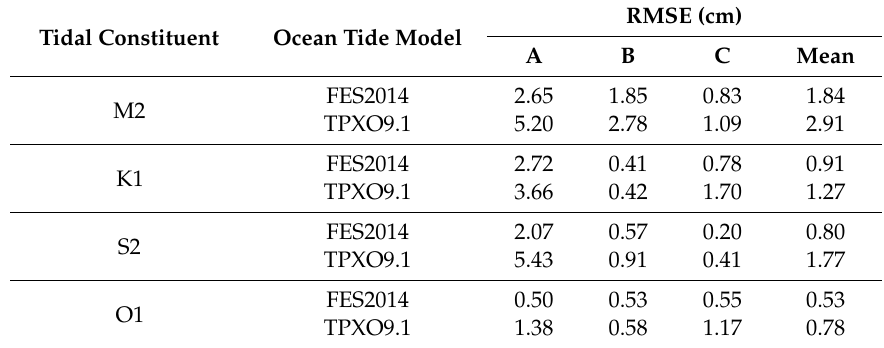
Table A11. Averaged di ff erence of interpolated amplitude on open boundaries (cm). Tidal Constituent Ocean Tide Model